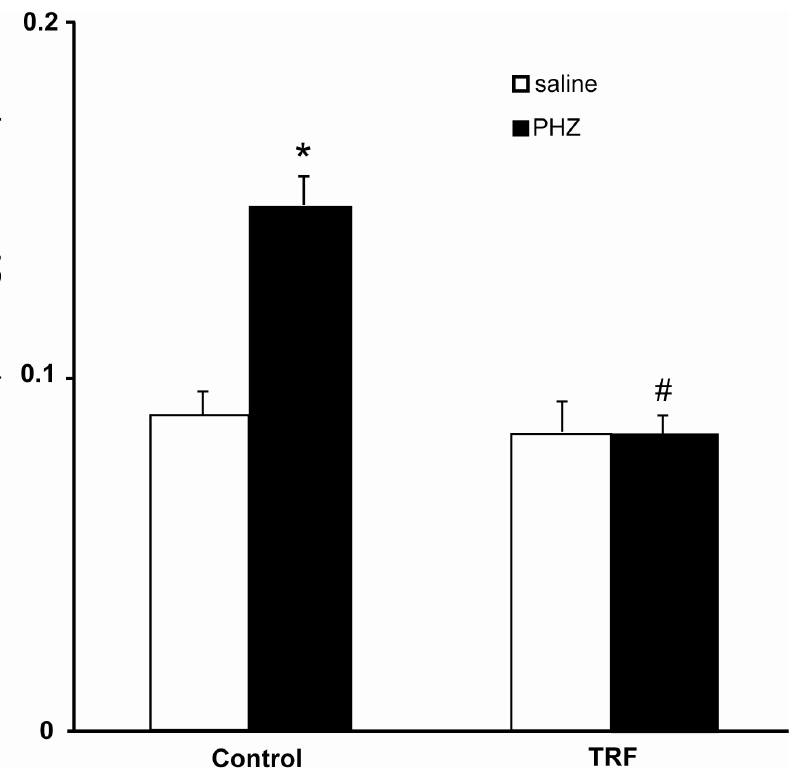
Figure 4. Hepatic biliverdin reductase activity. Bars represent mean 6 standard error (n=6). *Different from the control + saline group (p , 0.05). [TRF: tocotrienol-rich fraction; PHZ: phenylhydrazine].